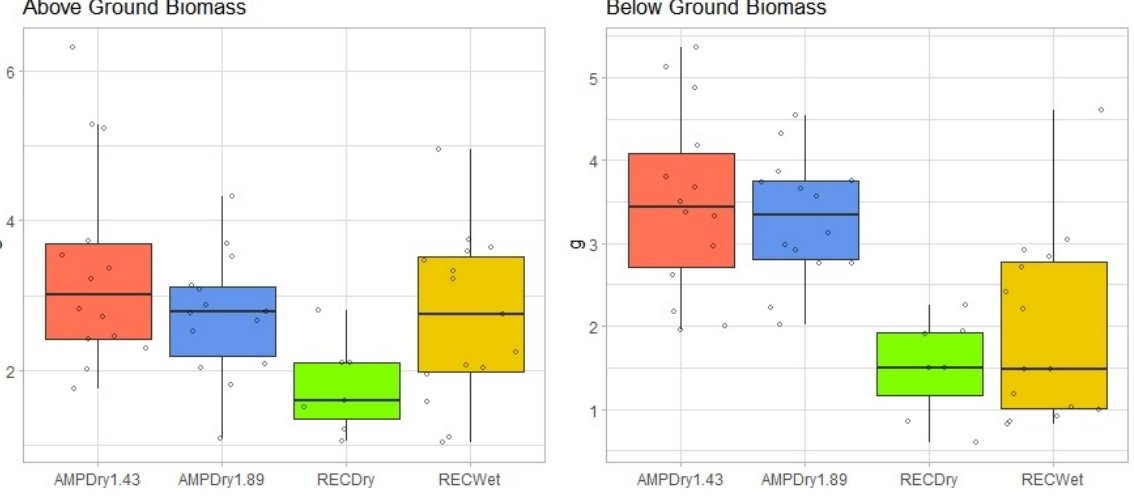
Figure 6. Differences in above- and below-ground biomass (g) assessed by treatment at the end of the experimental period.